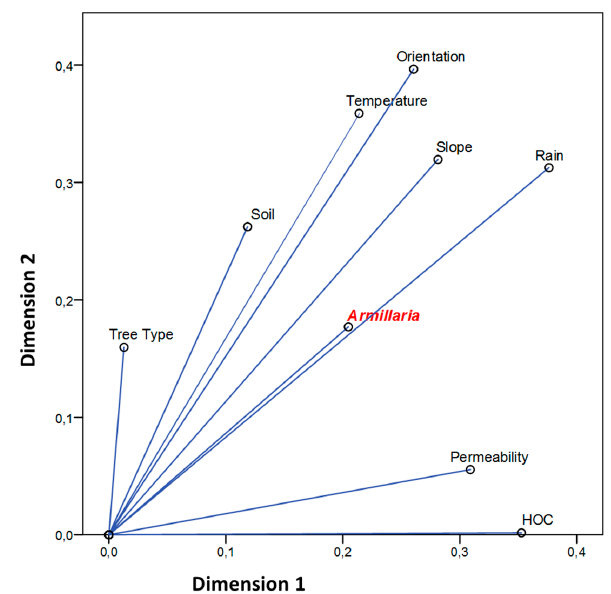
Figure 3. Measure of the variance of each variable for each dimension. The variables with higher variance in the first dimension were mainly average rainfall (Rain), optimal conditions for host growth (Hoc), slope, Armillaria spp., soil permeability and stand orientation (Figure 3). The variables with higher variance in the second dimension were orientation, average temperature (Temperature), average rainfall (Rain), slope, and soil acidity (Soil).